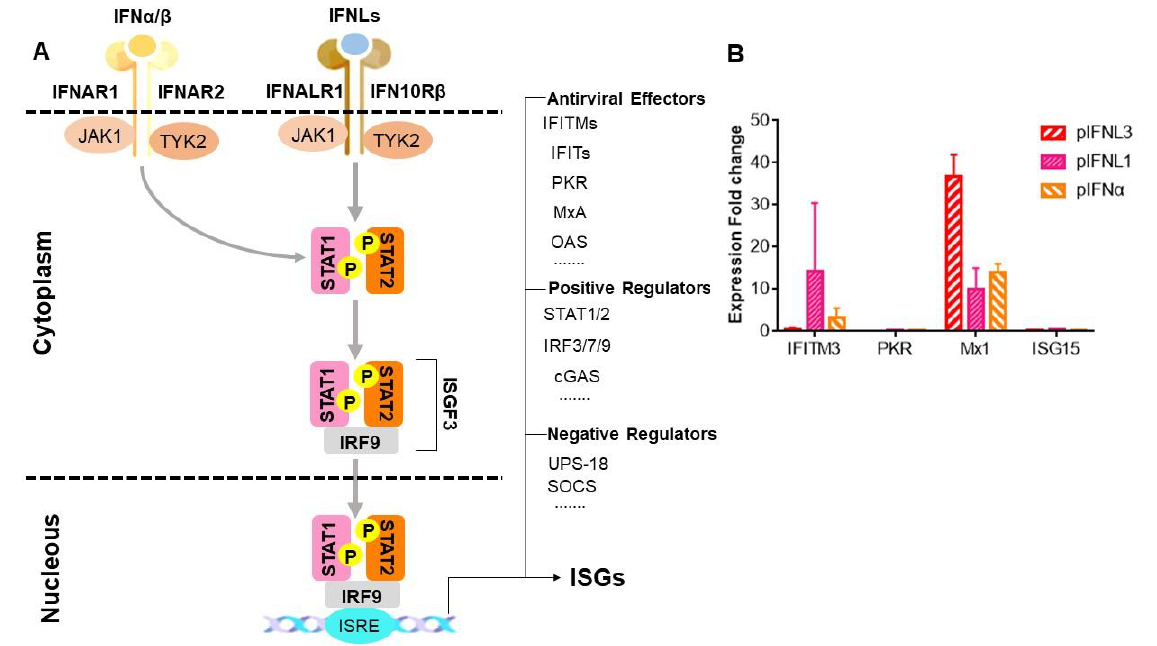
Figure 5. pIFNLs induced ISGS production. ( A ) Pattern diagram of ISG induction, induced by IFN. IFN interacts with the IFN receptor complex and initiates the formation of the ISGF3 transcription factor through the JAK-STAT pathway. The ISG induction, which determines the host ’ s antiviral state, depends on the ISGF3 nuclear translocation and interaction with the ISRE promoter. ( B ) Transcriptional profiling of the IFITM3, double-stranded RNA-dependent protein kinase (PKR), Mx1. and interferon-stimulated gene 15 (ISG15) genes after the pIFNL-treated ST cells. The shown fold induction is the average performed in triplicate.